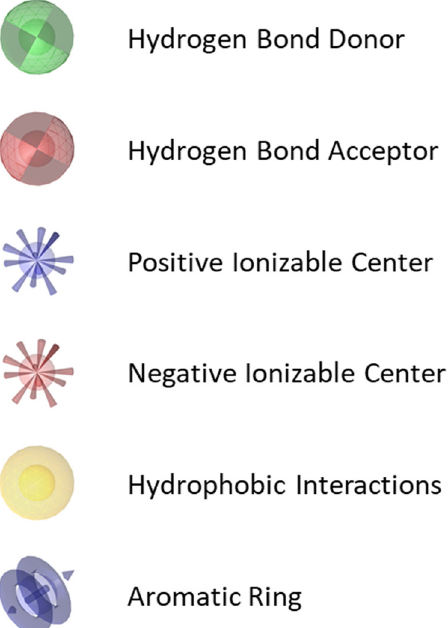
Fig. 1 Pharmacophore features and their color codes.